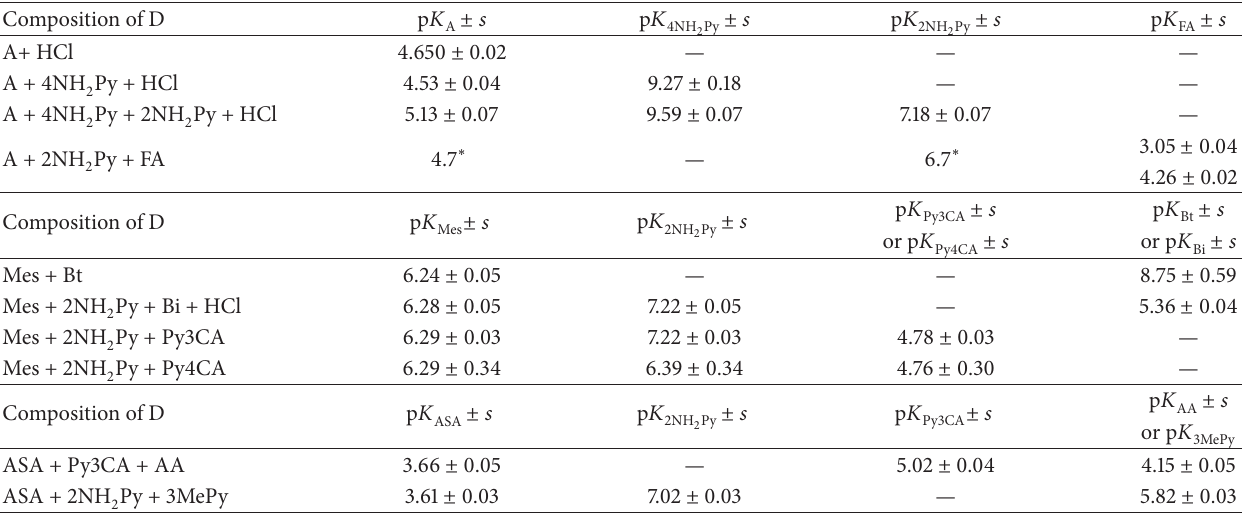
Table 5: The p 𝐾 ’s values of compounds determined in the multicomponent mixture of amines, heterocyclic moiety, and weak (Mes) and a strong (HCl) acids at 25 ∘ C.